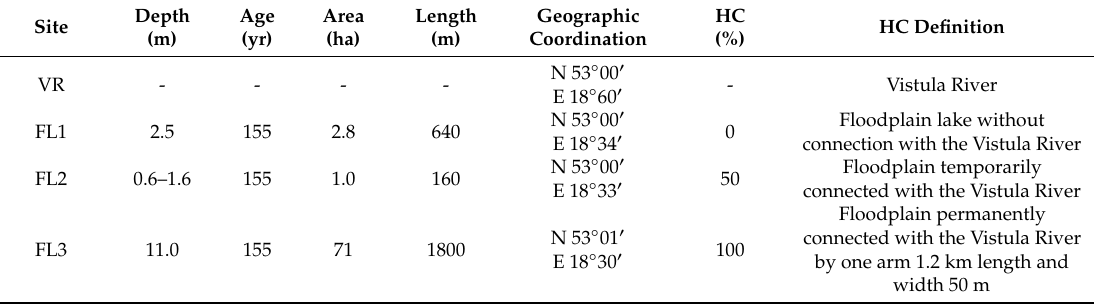
Table 1. Lateral hydrological connectivity definitions for floodplain lakes of the lower Vistula River. Type corresponds to categories of hydrological connectivity (HC). Depth is at the deepest part of the floodplain lakes in 2006–2013. Age is the time since the cuto ff of floodplain lakes, or construction, depending on